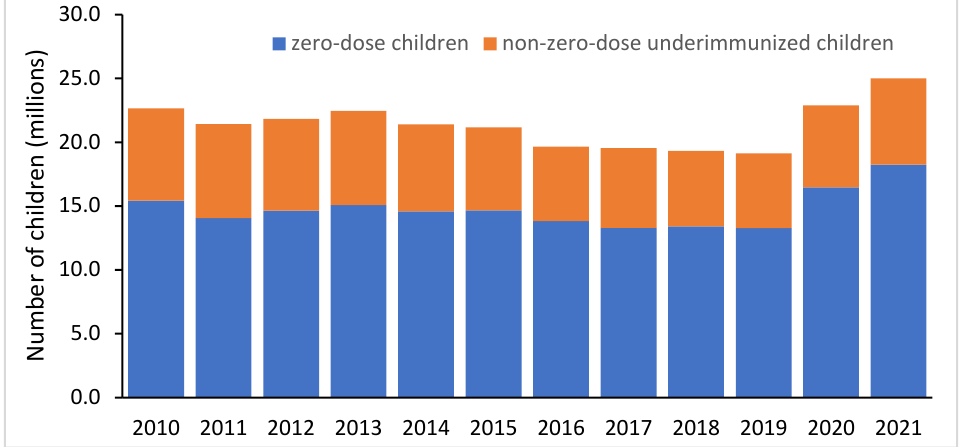
Figure 1. Annual number of zero-dose children and non-zero-dose underimmunized children globally, 2010–2021. Data source: WHO/UNICEF Estimates of National Immunization Coverage (WUENIC), July 2022 [8].